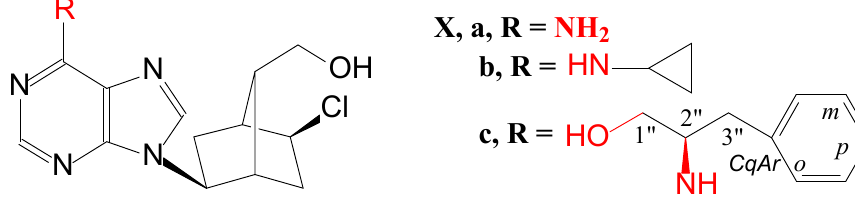
Figure 3. L -Carbanucleosides with an optically active bicyclo[2.2.1]heptane scaffold with potential anti-influenza and coxsackie B4 viruses.